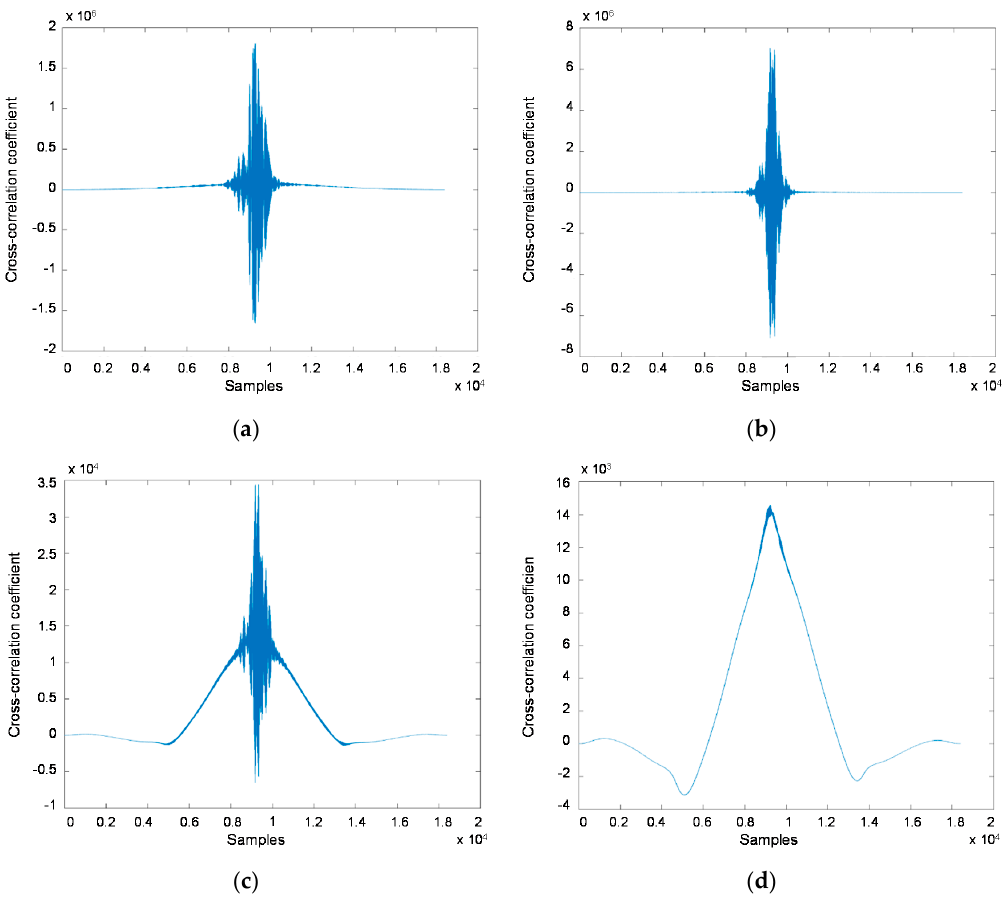
Figure 9. Cross-correlation between undamaged and damaged WTB: ( a ) 200–300 mm; ( b ) at 700–800 Figure9. Cross-correlationbetweenundamagedanddamagedWTB:( a )200–300mm; ( b )at700–800mm; mm; ( c ) at 2,300–2,400 mm; and ( d ) 2,900–3,000 mm. ( c ) at 2,300–2,400 mm; and ( d ) 2,900–3,000